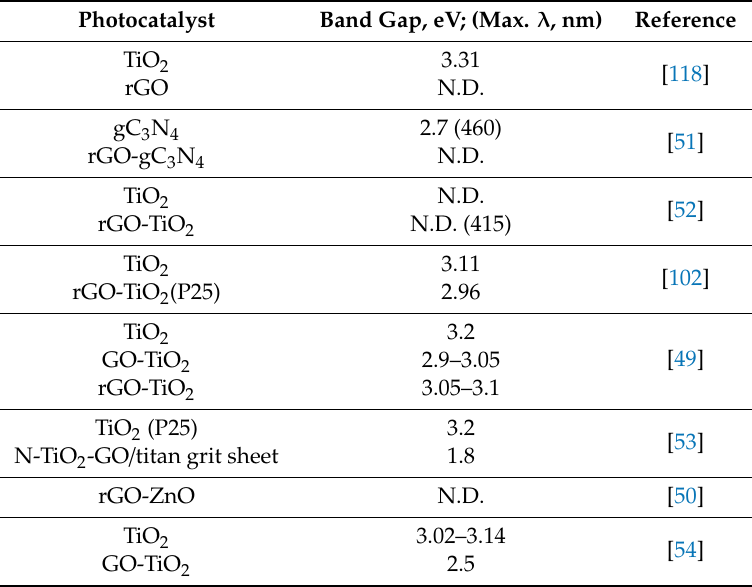
Table 4. Band gap values of GO-based